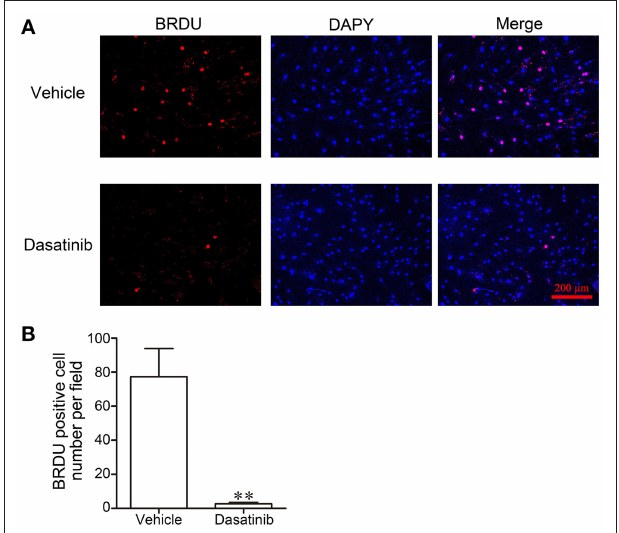
FIGURE 6 | The effect of dasatinib on FLS proliferation in RA patients was evaluated using BrdU staining. (A) Microscope observation of FLS treated with dasatinib and control vehicle. (B) The number of BrdU-positive cells in each field. ** P < 0.01 vs. vehicle group ( n = 4 per group).